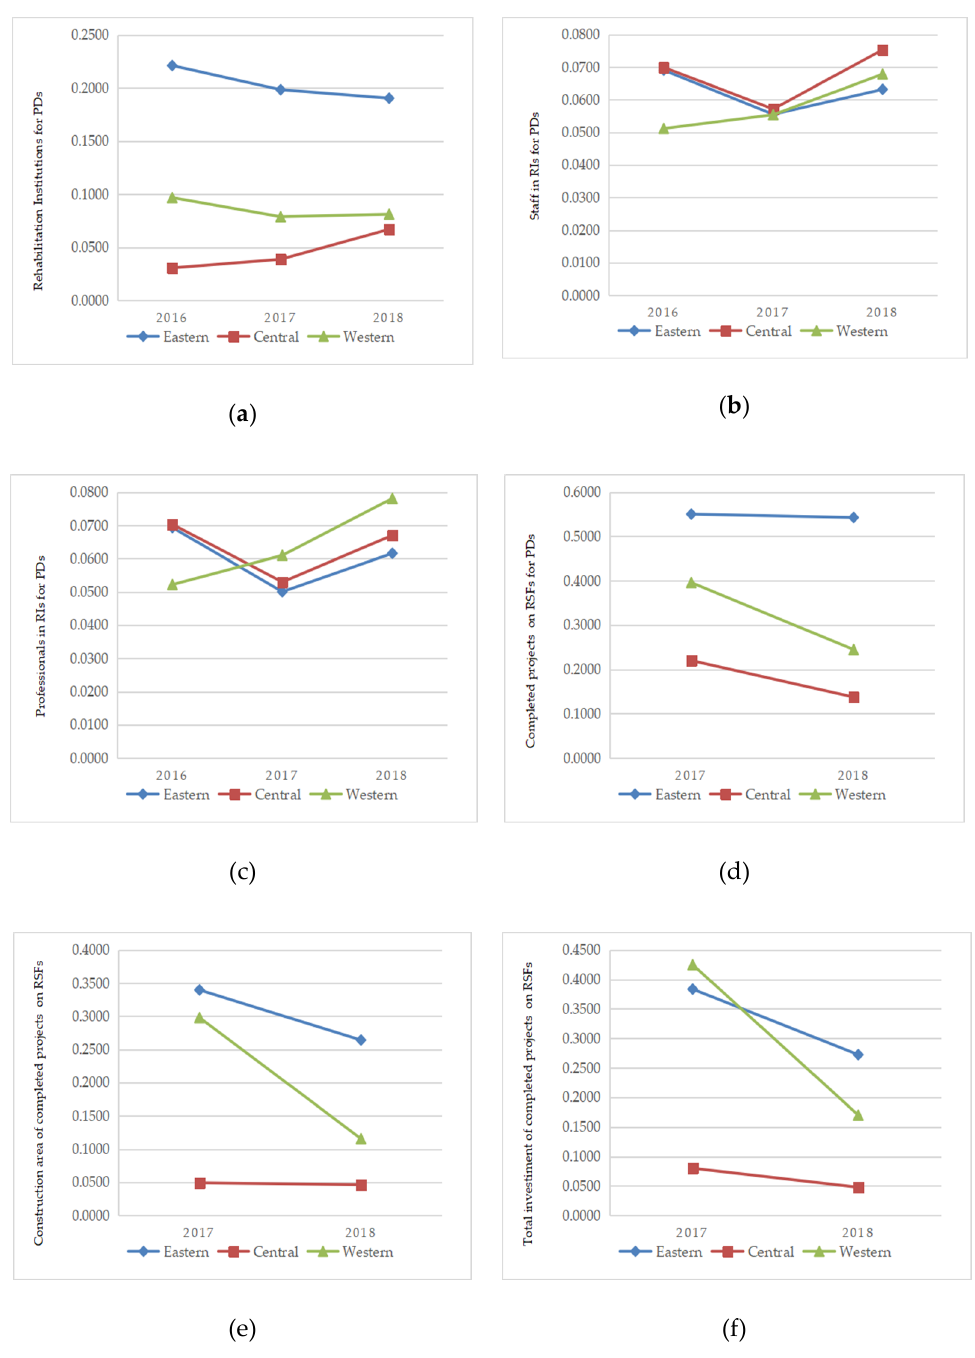
Figure 1. The regional Theil Index trends of six types of rehabilitation resources (which showed from (a) to (f) respectively) in China from 2016 to 2018. (a) Theil index values of RIs for PDs from 2016 to 2018 in the three regions; (b) Theil index values of staffs in RIs for PDs from 2016 to 2018 in the three regions; (c) Theil index values of professionals in RIs for PDs from 2016 to 2018 in the three regions; (d) Theil index values of completed Projects on RSFs for PDs from 2017 to 2018 in the three regions; (e) Theil index values of construction area of completed projects on RSFs from 2017 to 2018 in the three regions; (f) Theil index values of total investment of completed projects on RSFs from 2017 to 2018 in the three regions.